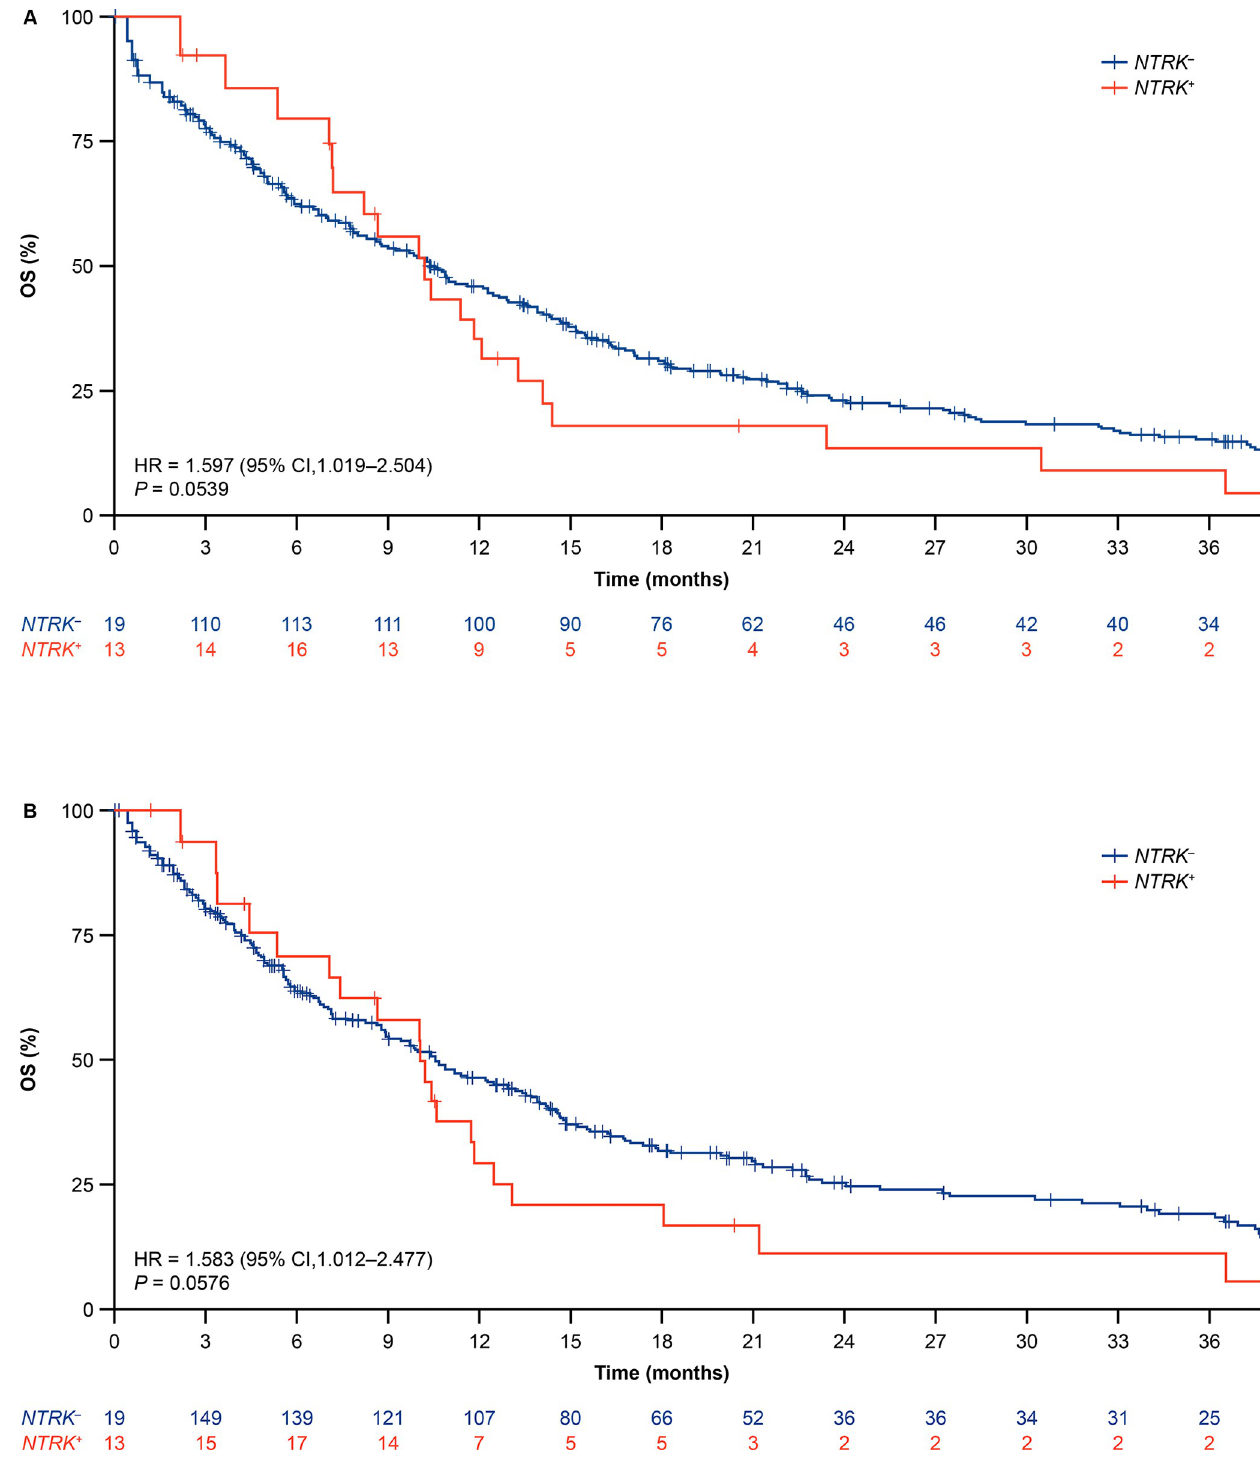
Fig 2. Kaplan-Meier curve of overall survival for the NTRK + versus matched NTRK − cohorts using (A) index date as the date of diagnosis of locally advanced/metastatic disease adjusted for left truncation and (B) index date as the start date of the last treatment line before NGS test report, or locally advanced/metastatic disease if no line of therapy received and adjusted for left truncation. Abbreviations: CI, confidence interval; HR, hazard ratio; NGS, next generation sequencing; NTRK - , neurotrophic tropomyosin receptor kinase fusion-negative; NTRK + , neurotrophic tropomyosin receptor kinase fusion- positive; OS, overall survival. Due to immortal time bias and delayed entry, not all patients entered the risk set at t0.